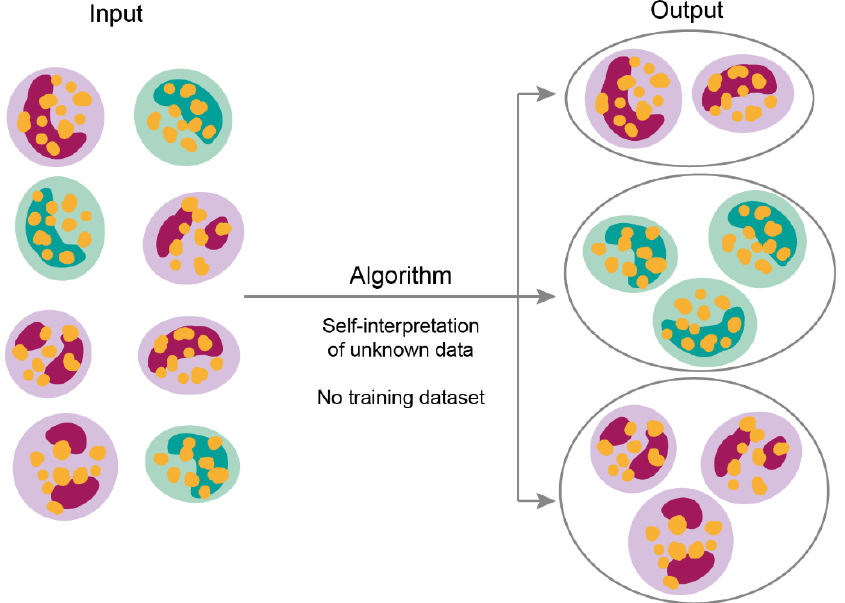
Figure 3. Unsupervised learning model. The algorithm extract features itself from the unknown input data without training. Hence the algorithm can cluster data with a similar component, which differentiates data from other objects or groups.